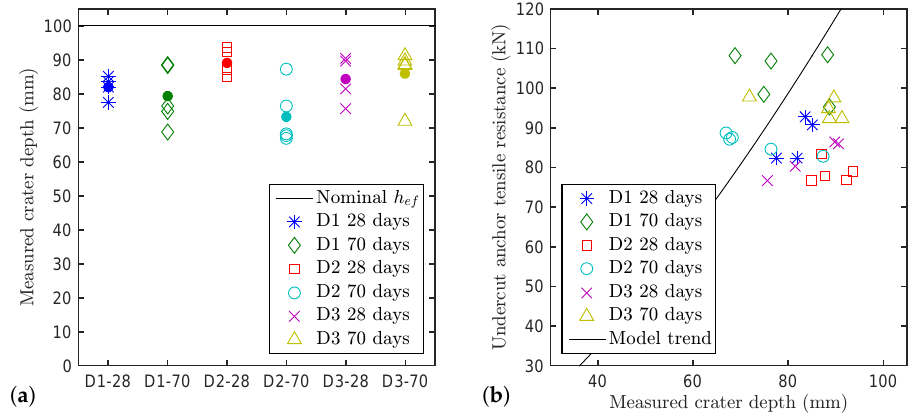
Figure 4. ( a ) Measured concrete crater depth (dots represent the average of the relative group of results); and ( b ) correlation between anchor tensile capacity of a single undercut anchor and its crater